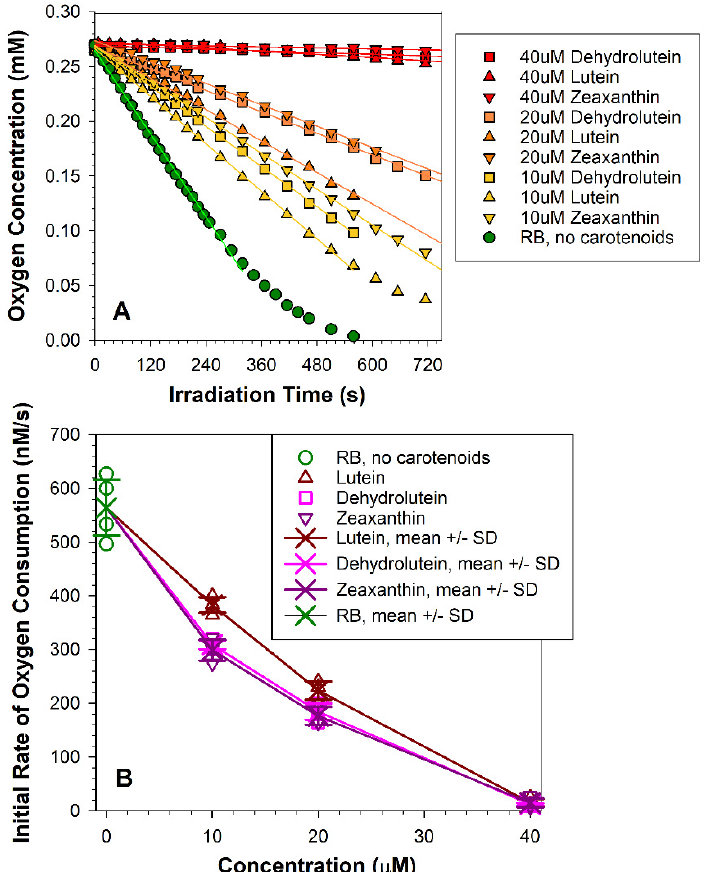
Figure 3. Dehydrolutein inhibits rose-bengal-mediated photo-oxidation with similar efficiency to lutein and zeaxanthin . ( A ) Representative kinetics of oxygen consumption during exposure to rose bengal and green light of liposomes in the absence and presence of carotenoids at indicated concentrations. Liposomes, consisting of 1 mg/mL egg yolk phosphatidylcholine (EYPC), 2.6 mM cholesterol, 11.8 mM 1,2-dimyristoyl-sn-glycero-3-phosphocholine (DMPC), and indicated concentra- tion of carotenoids were exposed to green light (542 ± 4 nm, 14.0 mW/cm 2 ) in the presence of 16- µ M rose bengal (RB). The samples included 0.1 mM, 4-protio-3-carbamoyl-2,2,5,5-tetraperdeuteromethyl- 3-pyrroline-1-yloxy (mHCTPO) used as a spin probe. The initial linear portions of the kinetics were fitted to straight lines, and the slopes of these lines gave initial rates of oxygen consumption. ( B ) The initial rates of oxygen consumption in the absence and presence of indicated carotenoids as a function of carotenoid concentration. Statistically significant differences between the initial rates of oxygen consumption in the presence of carotenoids used at the same concentration were only for 10 µ M lutein, which was significantly faster than for 10 µ M dehydrolutein or zeaxanthin ( p = 0.005 and 0.002,